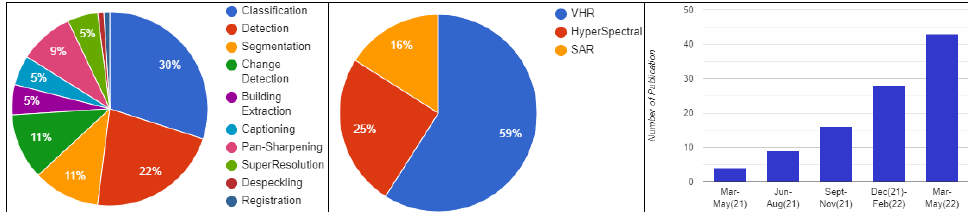
Figure 1. Recent transformer-based techniques in the remote sensing imaging. On the left and middle: pie-charts are representing statistics of the articles covered in this survey in terms of different remote sensing imaging problems and data type representations. On the right: we show a plot illustrating the consistent increase in the number of papers